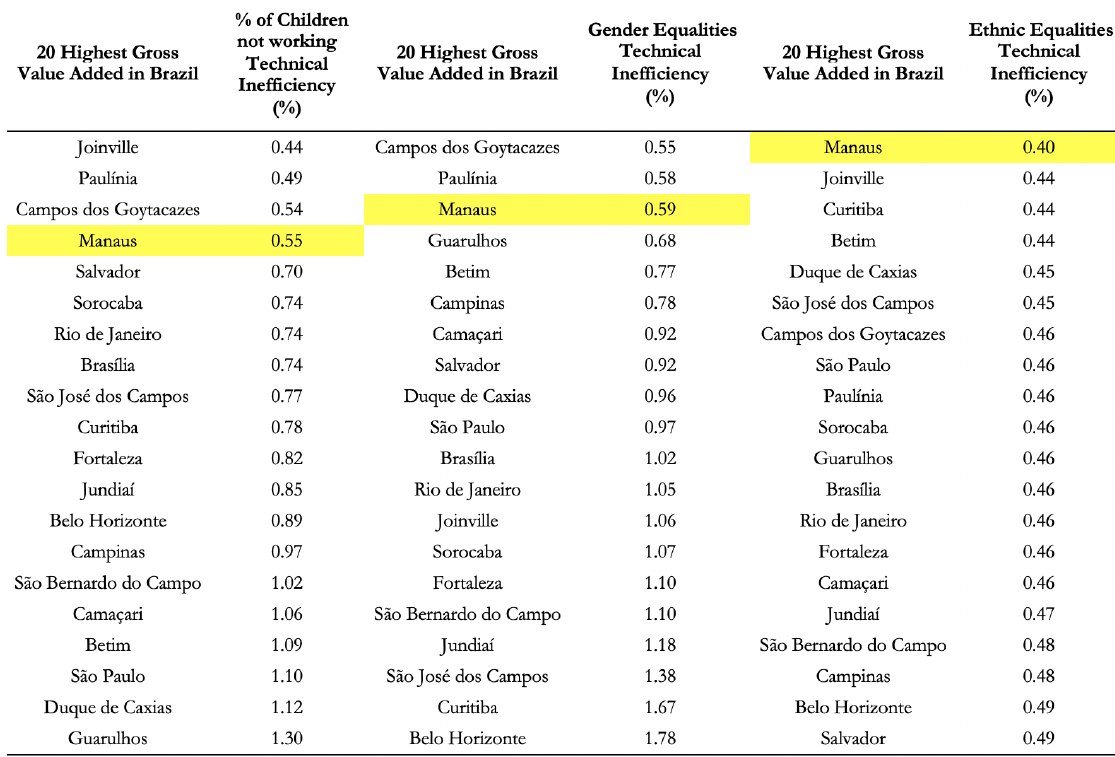
Table 13: Ranking of Labor Standards Inefficiency (Model B) - per 20 municipalities with the highest industry Gross Value Added in Brazil, per variable